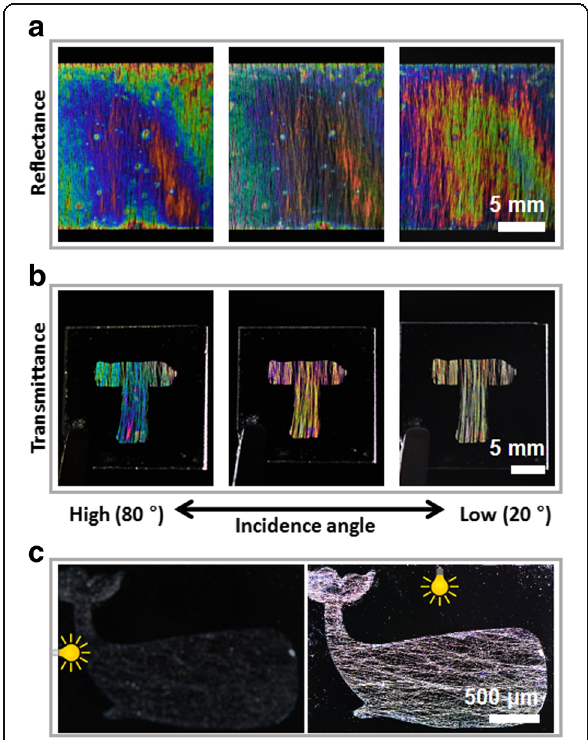
Fig. 4 Change of color of a structural pattern as a function of incidence angle on a a reflecting substrate and b transparent substrate. c Effect on pattern visibility by the orientation of incident light relative to the alignment direction of the nanofibers. Left: perpendicular, right: parallel